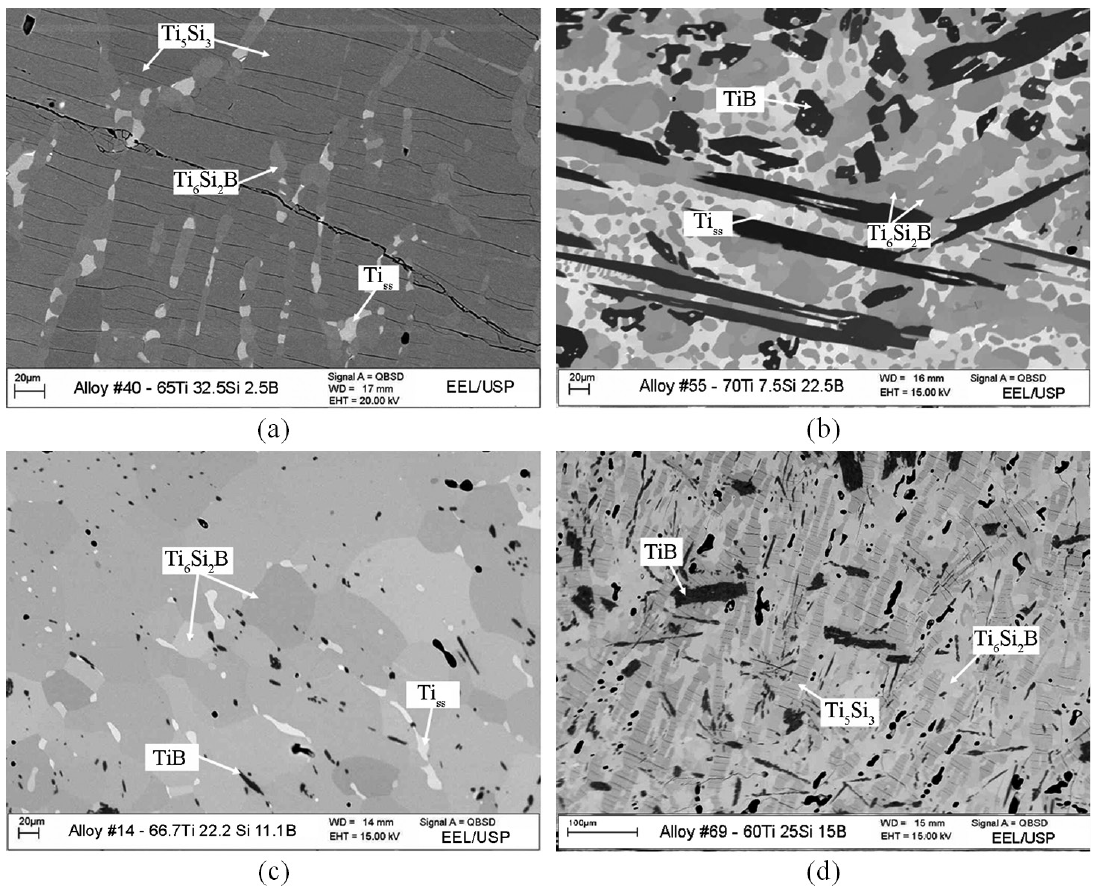
Figure 3. SEM/BSE micrographs from heat-treated Ti-Si-B alloys: (a) #40 (65Ti-32.5Si-2.5B); (b) #55 (70Ti-7.5Si-22.5B); (c) #14 (66.7Ti-22.2Si-11.1B); (d) #69